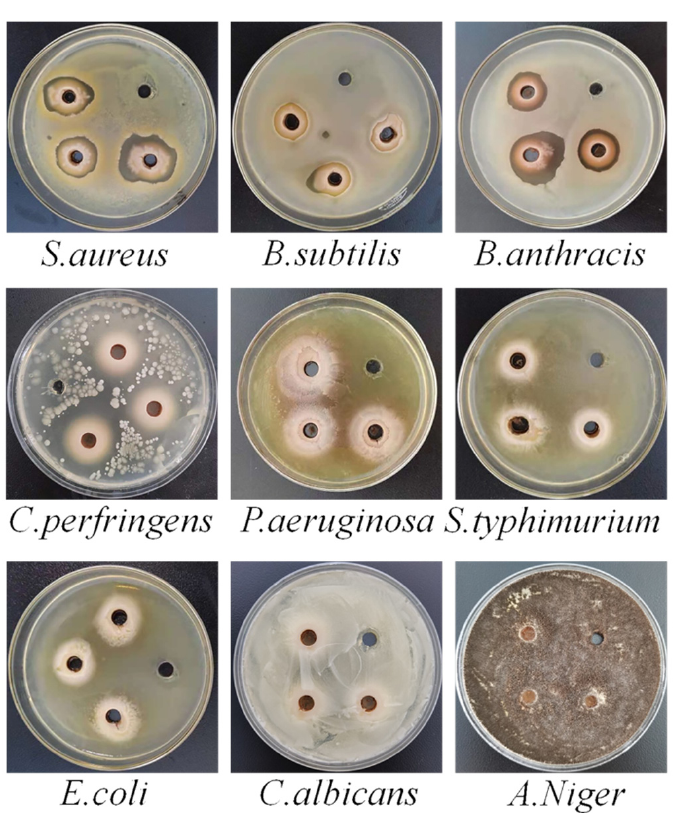
Figure 5. Photographs of inhibition zone experiment for 500 mg/mL peony total flavonoids to 9 kinds of bacteria.